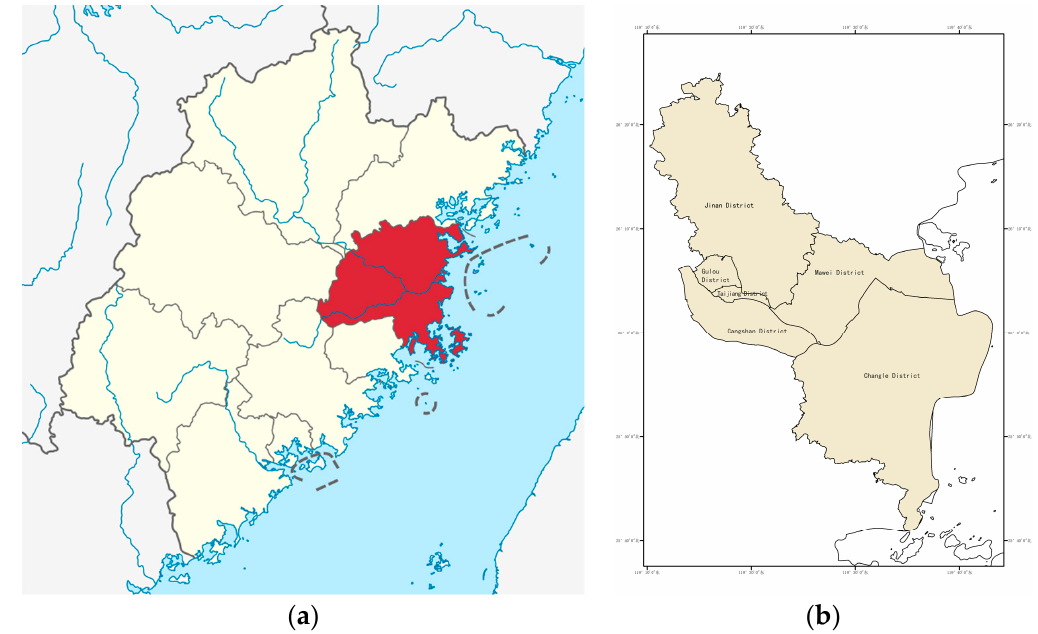
Figure 1. Geographic location of Fuzhou City and study area: ( a ) Fuzhou City location map; ( b ) Fuzhou City study area.